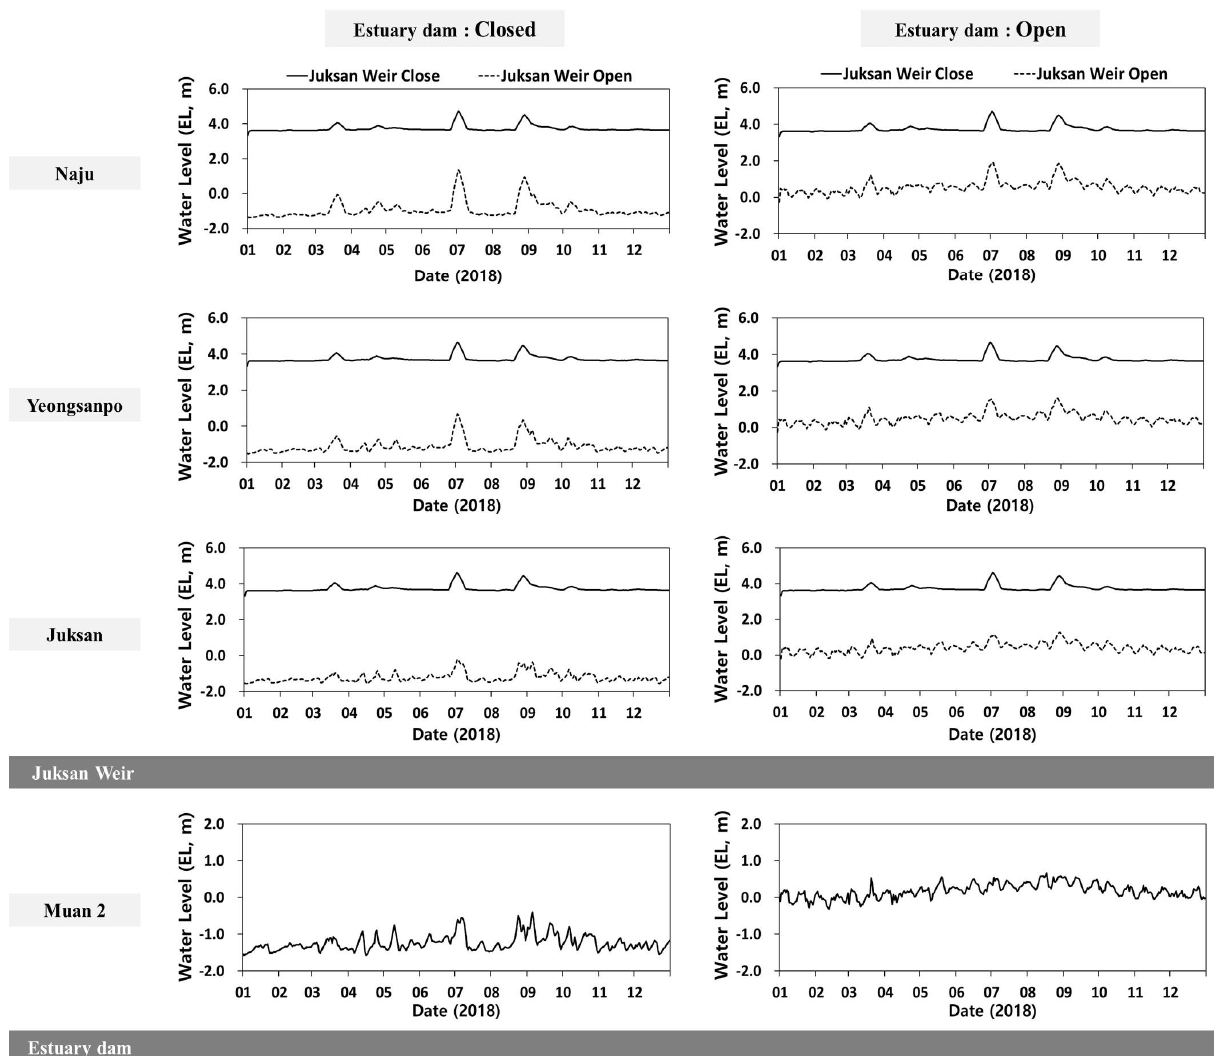
Figure 6. Simulated water levels according to the operating conditions of the Juksan Weir and estuary dam. Opening the Juksan Weir and estuary dam significantly decreased algal blooms due to reduced retention time and dilution due to seawater inflow. The number of cyanobacte- rial cells in the Juksan Weir section ranged between 3201 and 38,185 cells/mL when the Juksan Weir and estuary dam were closed; however, this number decreased by 72–84% to 889–6099 cells/mL when the Juksan Weir alone was opened. This is because the average retention time decreases from 11.2 to 1.8 days due to a reduction in water level, as shown in Table 7. Soballe et al. (1985, 1987) reported that algal abundance per unit of phosphorus increased in proportion to water residence time in the following sequence: rivers < im- poundments < natural lakes, and the residence time is a direct limitation to phytoplankton biomass [2,3]. Conversely, when both the Juksan Weir and estuary dam are opened, algal blooms in the Juksan Weir section are decreased by 0–32%, a smaller reduction than that when the Juksan Weir alone is opened. This is because the increased water level further reduces the water flow and increases the retention time under the direct influence of the outer tide